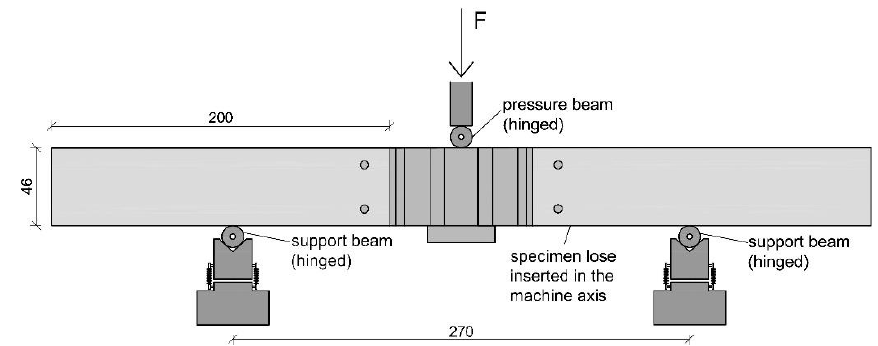
Figure 7. Test setup of the bending tests.